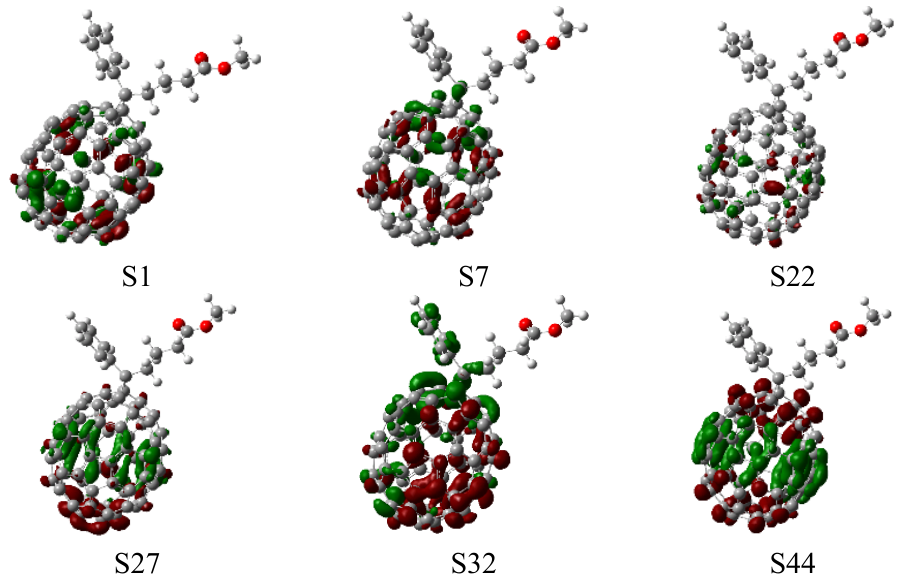
Figure 5. Charge difference density (CDD) of [C70]PCBM, where the green and red stand for the hole and electron, respectively.